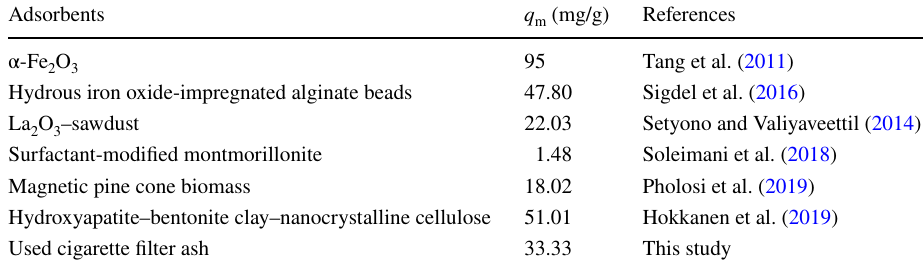
Table 5 Maximum adsorption capacity of different adsorbents for As(III) removal